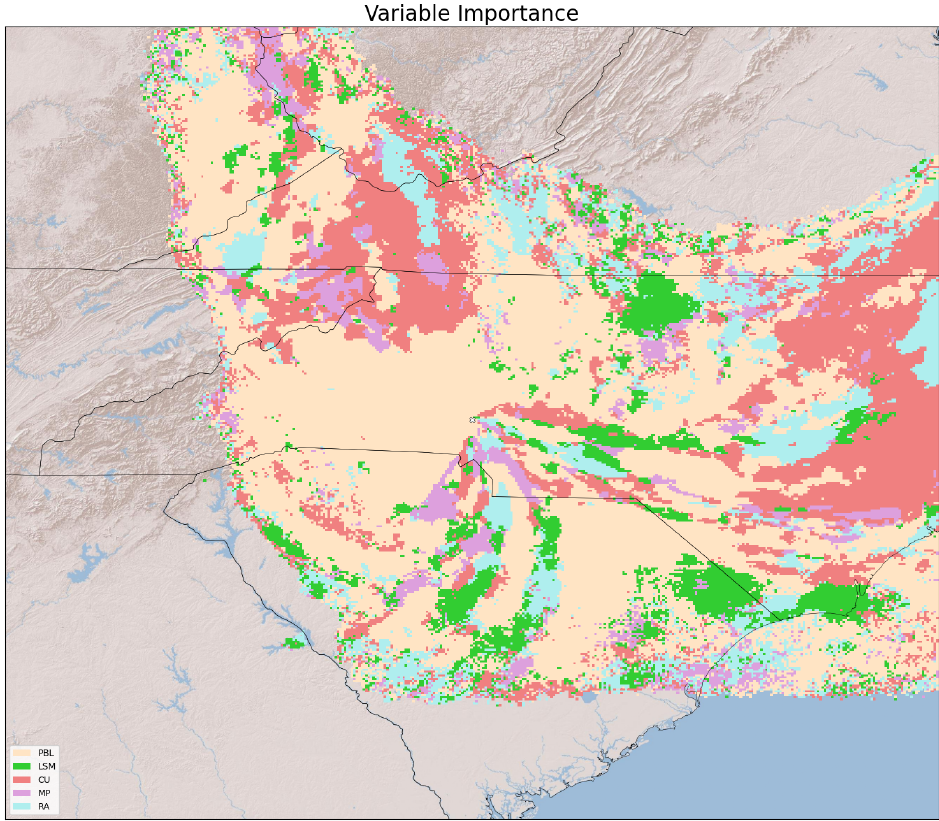
Figure 12. Primary WRF parameterization changes associated with Cs-137 deposition are color-coded and shown for every grid cell. Areas with 17 or fewer samples are excluded. The total training dataset included 50 ensemble members. In the legend, PBL stands for the planetary boundary layer physics parameterization (tan), LSM stands for land surface model (green), CU stands for cumulus physics (red), MP stands for microphysics (magenta), and RA stands for radiation